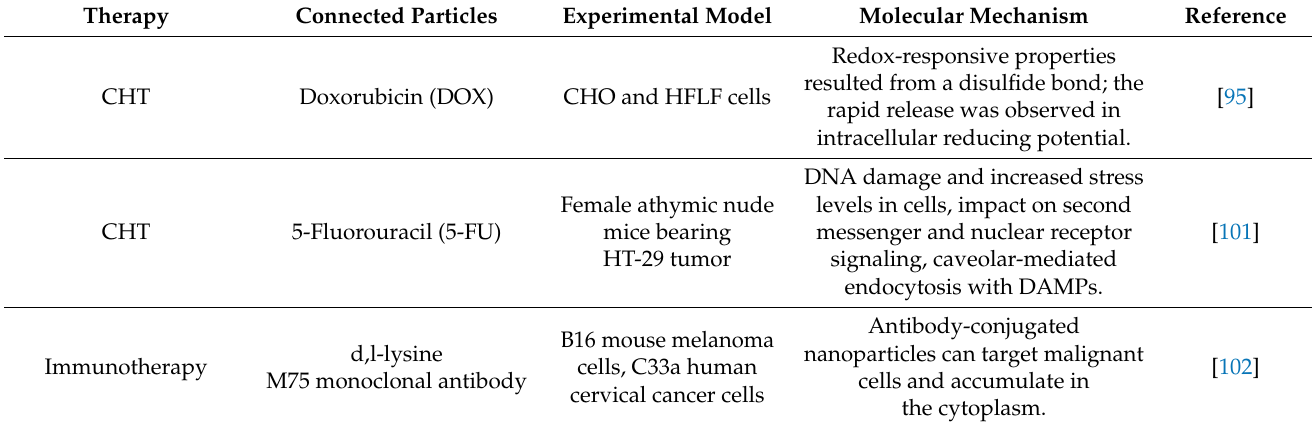
Table 9. Selected connections of biologically active molecules with iron nanoparticles. Therapy Connected Particles Experimental Model Molecular Mechanism Reference CHT Doxorubicin (DOX) CHO and HFLF cells